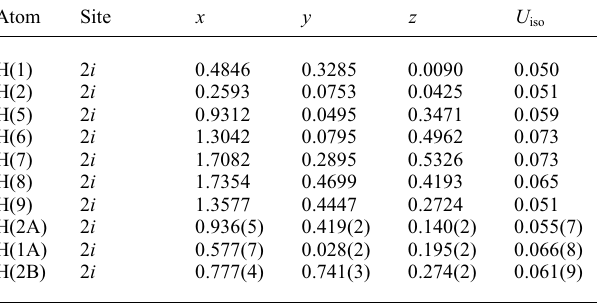
Table 2. Atomic coordinates and displacement parameters (in Å 2 ) .